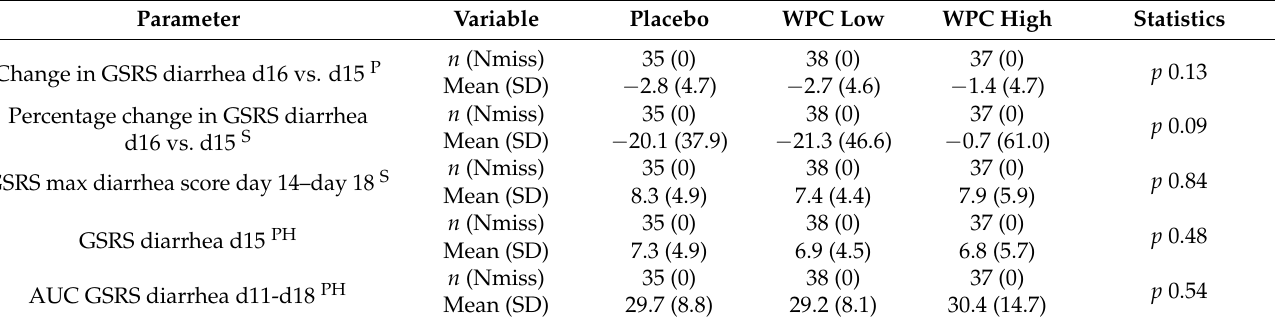
Table 4. Statistical study outcomes in relation to diarrhea.